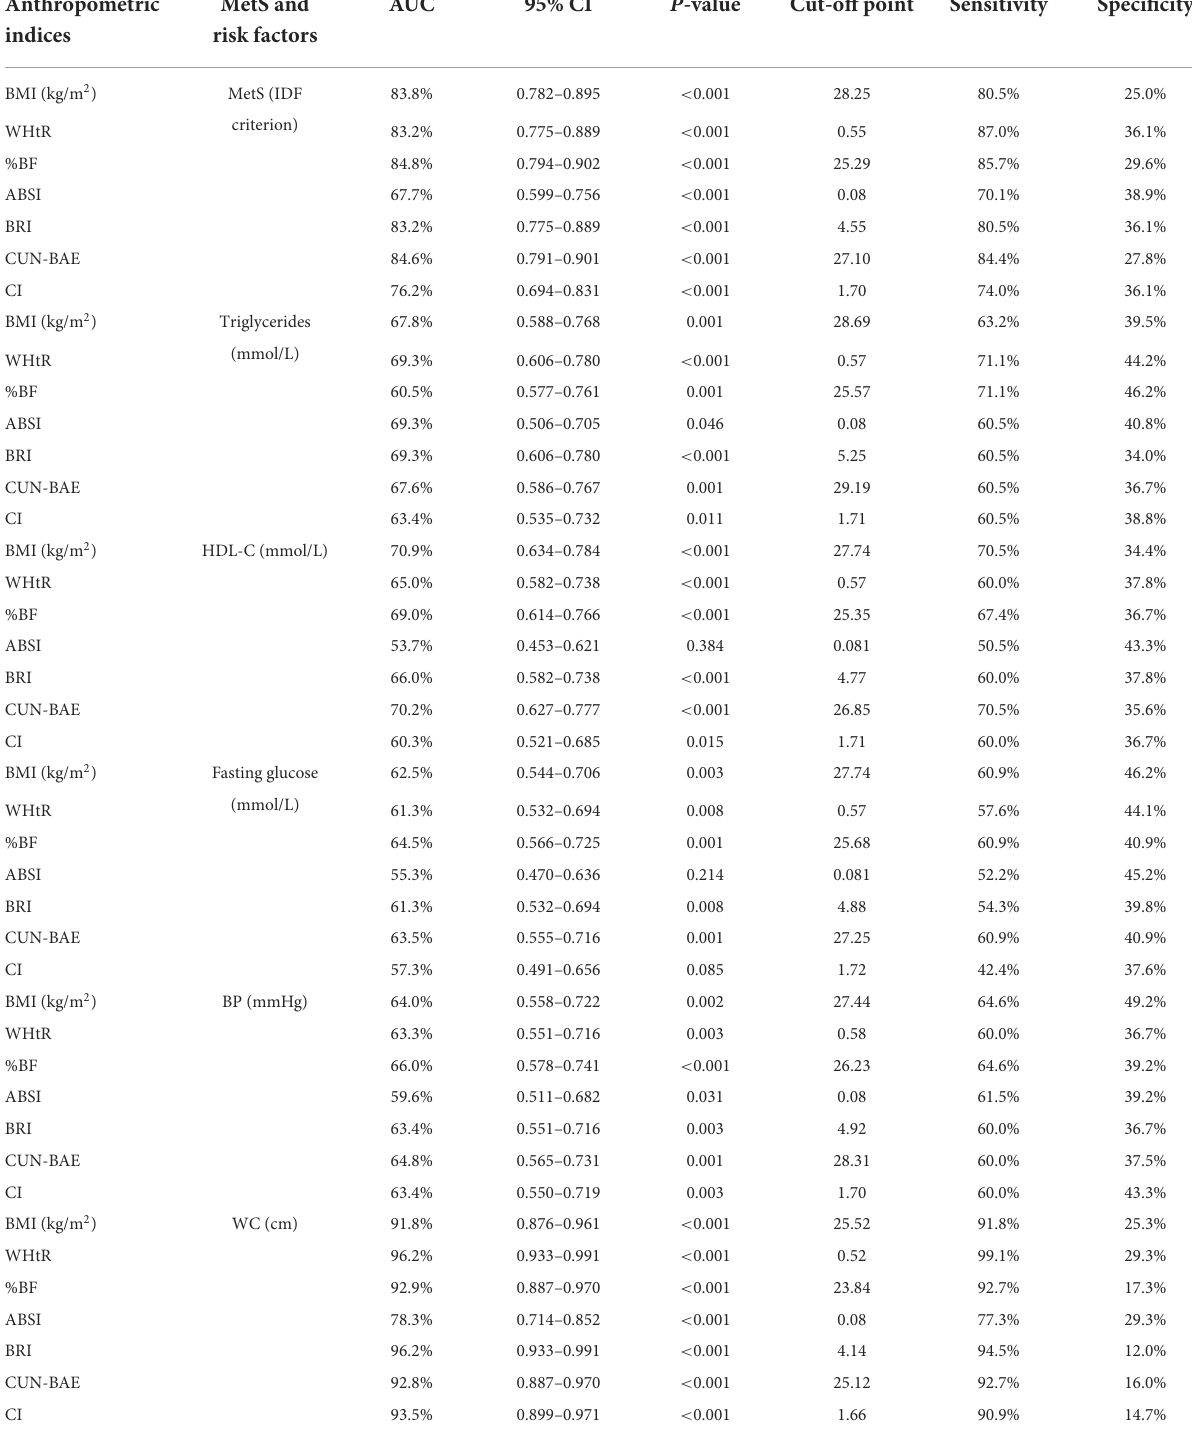
TABLE 4 Area under the curves (AUC) and cut-off points for the anthropometric indices for the prediction of MetS and its risk